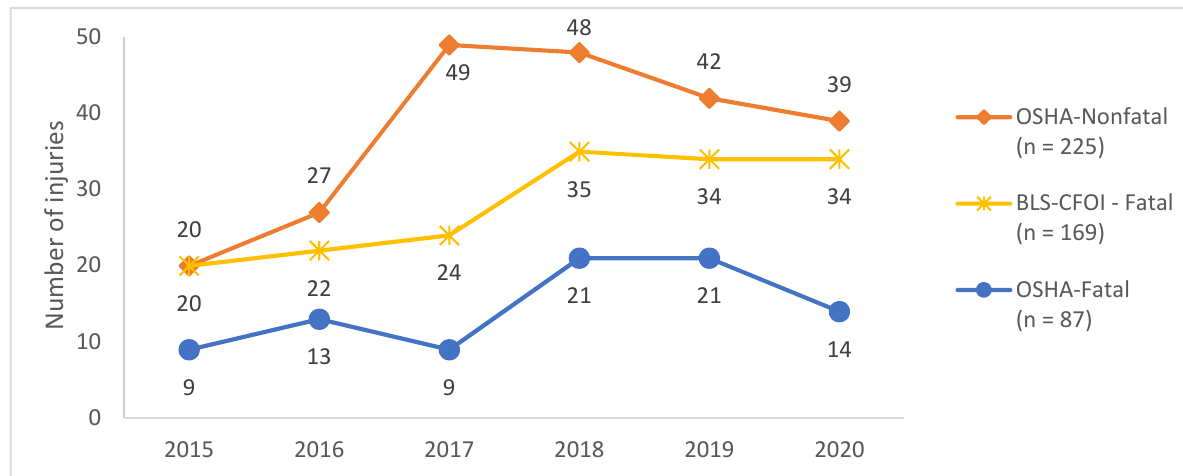
Figure 2. Fatal and nonfatal skid steer injuries by year. Table 2 provides summary results broken down by nature of injury and body parts injured. Fatal injuries mostly resulted from crushing injuries to the head, chest, and mul- tiple body parts ( n = 30); asphyxiations, strangulations, and suffocations ( n = 9); and mul- tiple traumatic injuries ( n = 8) (Table 2). Fatal injuries mostly involved multiple body parts, body systems, head and neck, and trunk. For nonfatal injuries, fractures were the most prevalent type of injury, followed by amputations. The lower extremities (i.e., feet, ankles, legs) were the most vulnerable to a nonfatal injury followed by upper extremities (mostly fingers). Amputations were to the fingers ( n = 17), fingertips ( n = 7), legs ( n = 4), feet ( n = 2), and toe ( n = 1). Table 2. Summary of injury cases by nature of the injury and injured body parts.